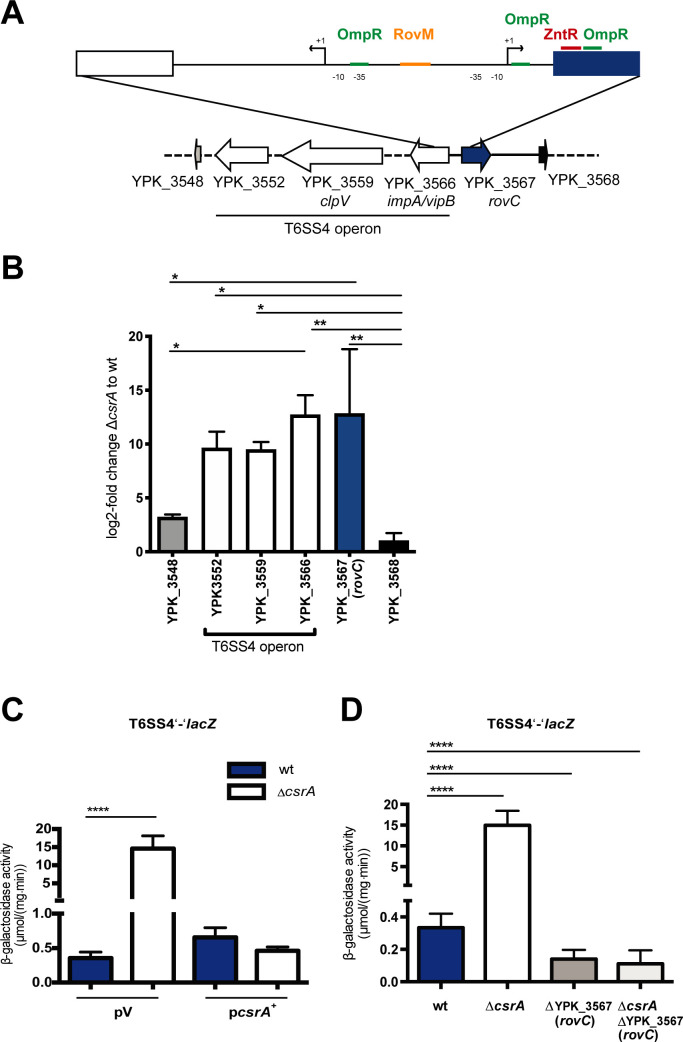
CsrA represses the expression of the T6SS4 gene cluster through regulation of rovC.(A) Schematic representation of the T6SS4 gene cluster of Y. pseudotuberculosis. The cluster (composed of 16 genes YPK_3550 to YPK_3566), encompassing a size of 23.6 kb is indicated with white arrows representing the tested T6SS4 genes. The rovC gene is found directly downstream of this cluster oriented in the opposite direction and is given by a blue arrow. The independently controlled up- and downstream genes are indicated in grey and black. (B) A qRT-PCR was performed with total RNA isolated from Y. pseudotuberculosis strain YPIII (wildtype) and the isogenic ΔcsrA mutant (YP53) with primer pairs specific for selected genes of the T6SS4 operon and genes upstream and downstream of the cluster. Gene expression levels were normalized to the sopB reference transcript according to Pfaffl 2001 [70] and log2 fold changes of ΔcsrA to wildtype were determined. The data represent the mean ± standard deviation of three independent experiments carried out in duplicate. Data were analyzed by one-way ANOVA, followed by Tukey’s test; *P < 0.0332, **P < 0.0021 (C) β-galactosidase activity (μmol/mg.min) expressed by a translational T6SS4’-‘lacZ reporter fusion (pSSE64) was monitored in the wildtype strain YPIII and the ΔcsrA mutant strain YP53 (ΔcsrA) harboring the empty vector pAKH85 (pV) and the csrA+ plasmid pAKH56 (pcsrA+) grown over night for 16 h at 25°C in LB medium. The data represent the mean ± standard deviation of three independent experiments, carried out in triplicates. Data were analyzed by Student’s t-test; ****P < 0.0001; *P < 0.05. (D) To analyze the role of rovC in T6SS4 regulation, expression of a translational T6SS4’-‘lacZ reporter fusion (pSSE64) was measured in the Y. pseudotuberculosis wildtype (YPIII), the ΔcsrA mutant (YP53), the ΔrovC mutant (YP148) and the ΔcsrA/ΔrovC double mutant (YP318). β-galactosidase activity (μmol/mg.min) was measured of strains grown over night for 16 h at 25°C in LB medium. The data represent the mean ± standard deviation of three independent experiments, carried out in triplicates. Data were analyzed by Student’s t-test; ****P < 0.0001.